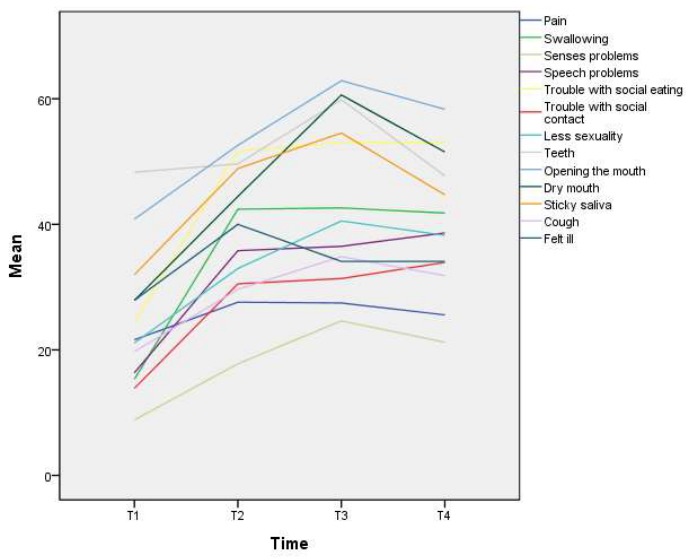
Figure 1. Oral cancer patients’ symptoms change over time.